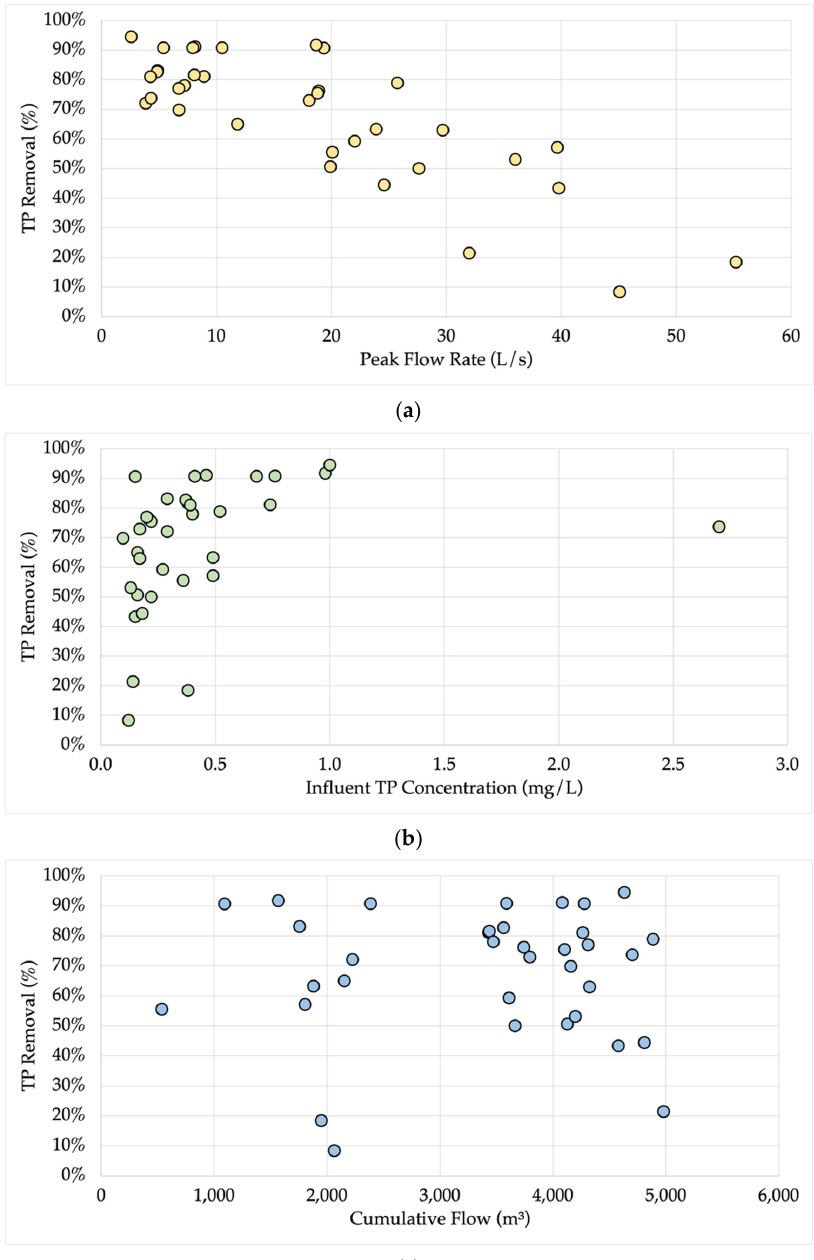
Figure 4. Event mean TP removal (%) plotted against ( a ) peak flow rate observed during storm event, ( b ) event mean TP concentration in stormwater, and ( c ) cumulative total of stormwater that flowed through the spent lime DWTR.